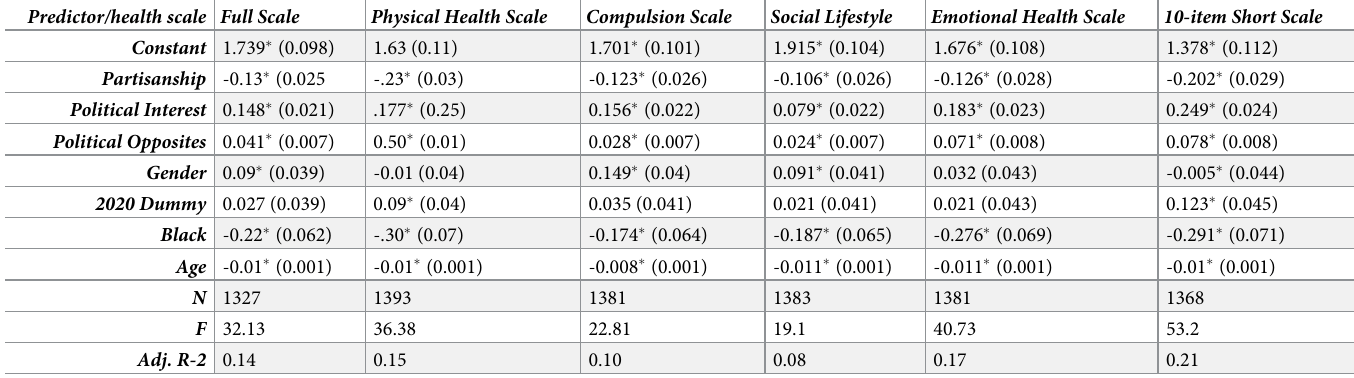
Fig 1. Mean politically-related health scores 2017–2020. Relationship between mean scores on all 32-items of Smith et al (2019) political costs health battery between 2017 and 2019. https://doi.org/10.1371/journal.pone.0262022.g001 statistically significant increases in the physical health scale and the short form (10 item) gen- eral scale. Higher numbers indicate greater health impacts, and the dummy variable coefficient estimates for these two scales an average increase of ~0.10 points between 2017 and 2020 on these scales. Though significant, these effect sizes are so small they should be interpreted with caution. Especially given that in all the other models the estimated 2017–2020 differences were Table 1. Regression models for combined 2017–2020